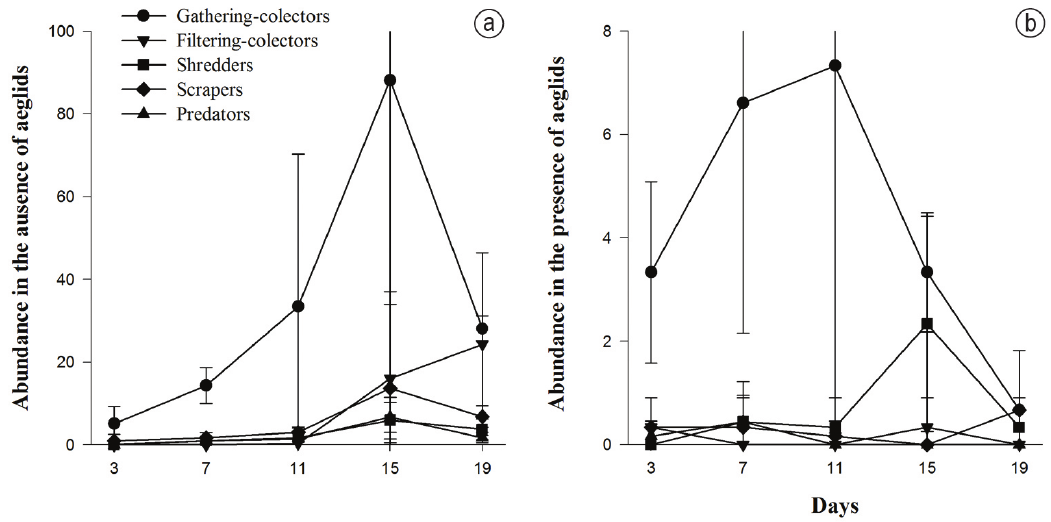
Figure 3. Abundance of the trophic groups on decomposing leaves after 3, 7, 11, 15 and 19 days of exposure to the stream in the absence (a) and presence (b) of A. longirostri . The bars indicate the standard deviation.